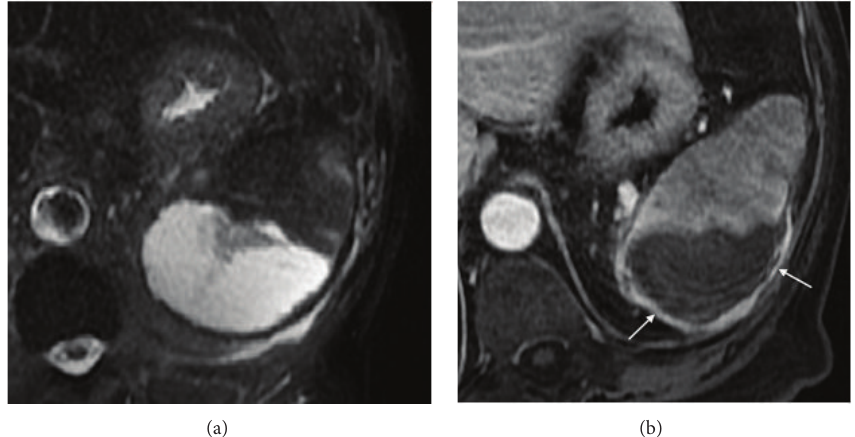
Figure 6: Splenic abscess. Axial T2wi SSFSE with fat suppression (a) and postcontrast axial T1wi 3D-GRE with fat suppression in the venous (b) phase. A large subcapsular splenic abscess is depicted. This lesion is marked hyperintense on T2wi and hypointense on T1wi with irregular margin. Note the faint enhancement of the splenic capsule (arrows, (b)).